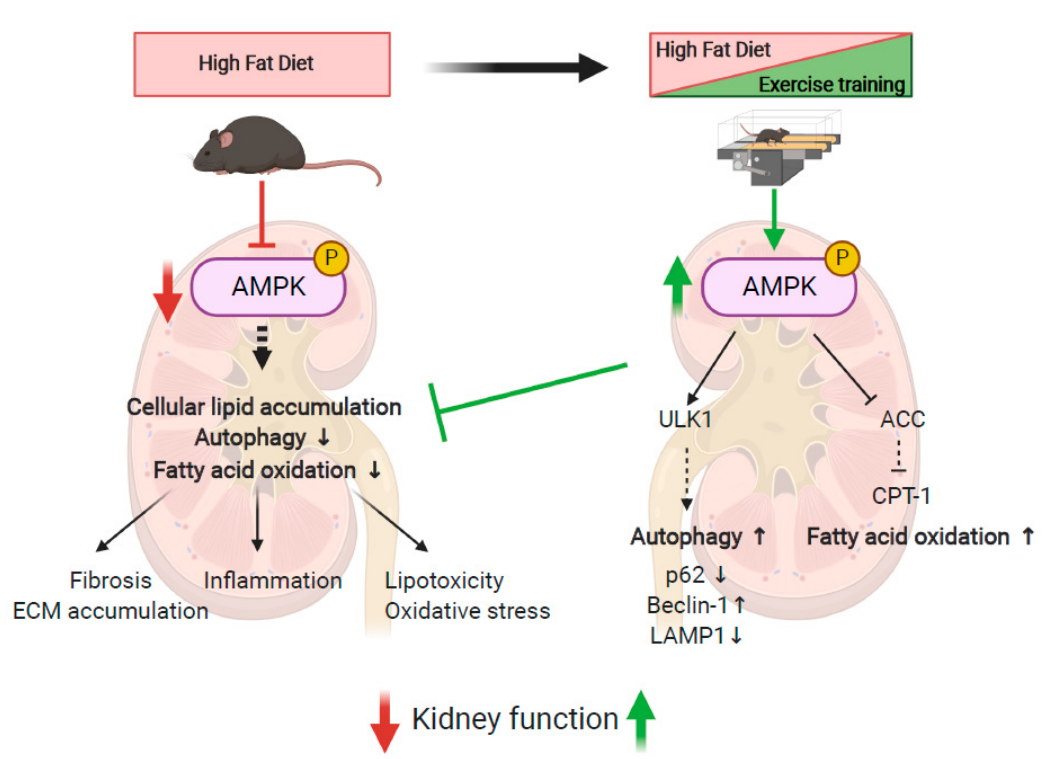
Figure 8. Schematical representation of the effects of HFD and EET on the underlying molecular mechanisms of obesity- induced CKD in mice. Created with Biorender.com.